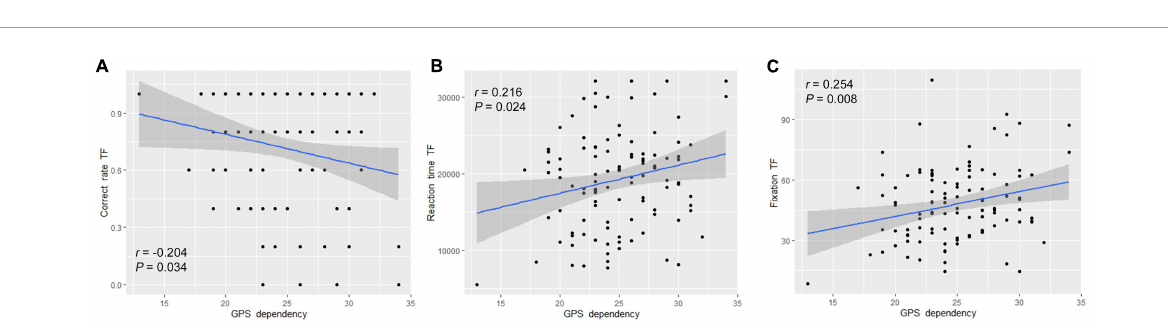
FIGURE5 Correlation between GPS dependency and indicators in eye-tracking TF task in the city. (A) Correct rate; (B) reaction time; (C) fixation. TF represents target finding